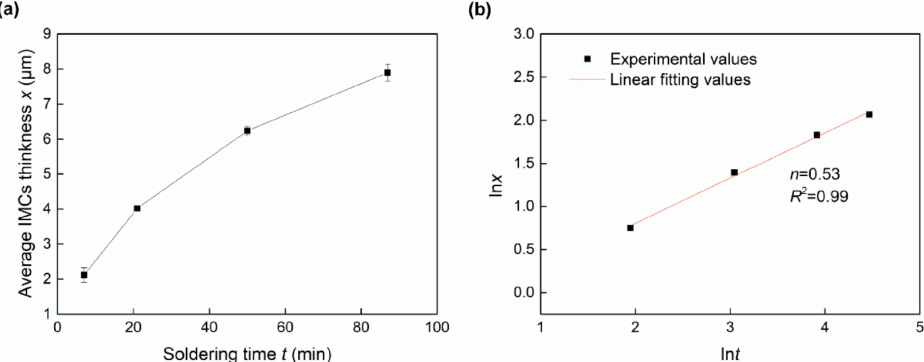
Figure 5. IMC layer thickness in one interfacial side vs. soldering time ( a ) x - t and ( b ) ln x -ln t .